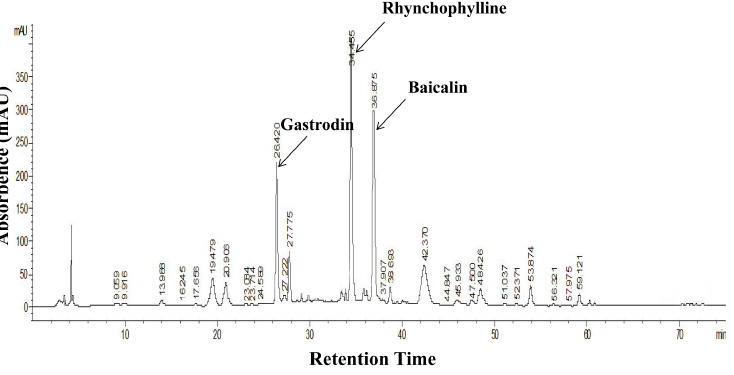
Figure 1. Representative Chromatographic fingerprint of QXJYD.